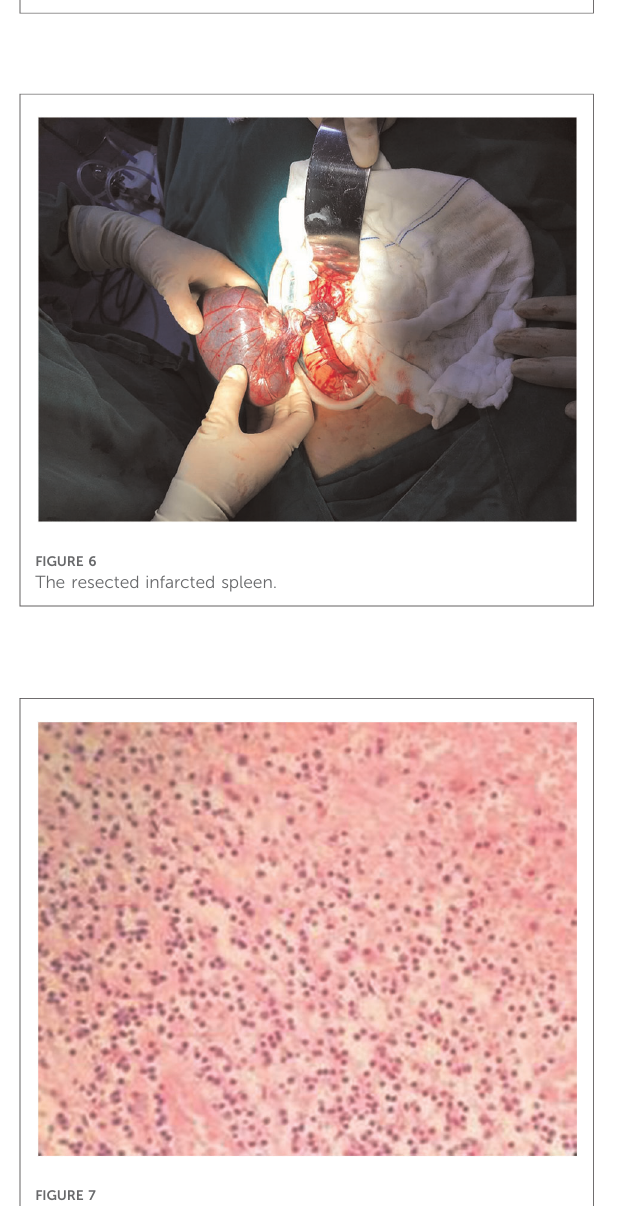
FIGURE 5 Dissection of the mesoappendix.